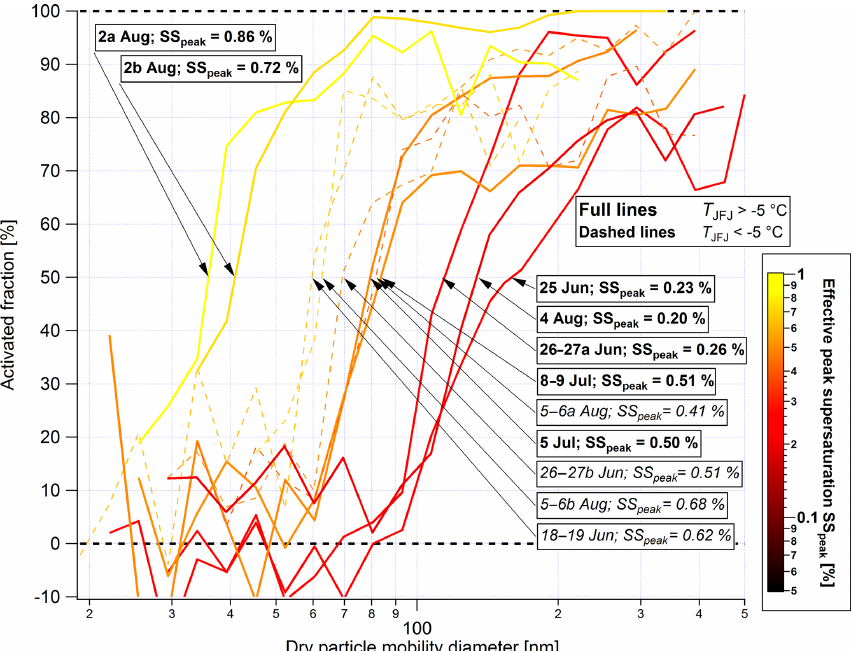
Figure 7. Fraction of particles activated to cloud droplets for each stable cloud period of the CLACE2016 campaign as derived from particle number size distributions measured by the SMPS behind the total and interstitial inlets. The lines are coloured by SS peak inferred from D cloud and κ smooth during the corresponding period. Periods of mixed-phase clouds are symbolized by dashed lines. For image clarity, error half bars are not shown on this graph but can be found in Fig. 2 for three of these cloud